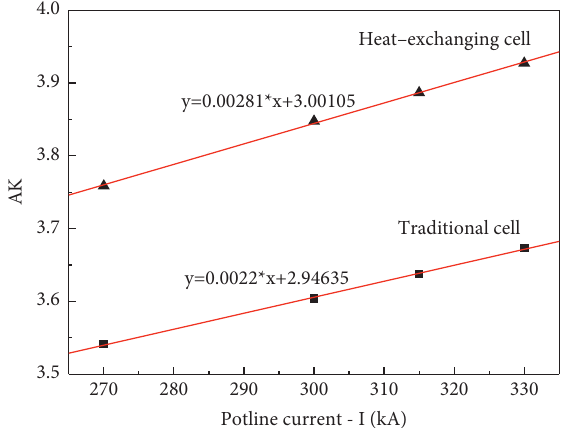
Figure 9: The relationships between the ( A · K ) value and potline current for the traditional cell and heat-exchanging cell, respec- tively (960 °